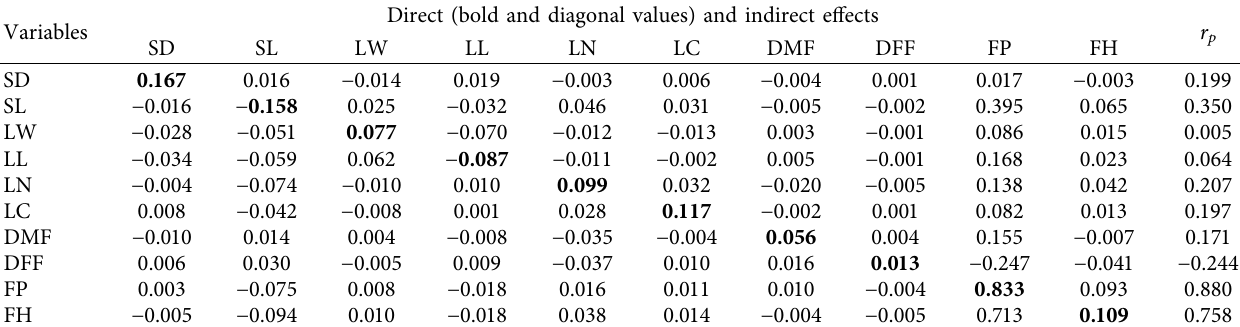
Table 5: Phenotypic path analysis among melon characteristics on fruit weight. Direct (bold and diagonal values) and indirect Variables